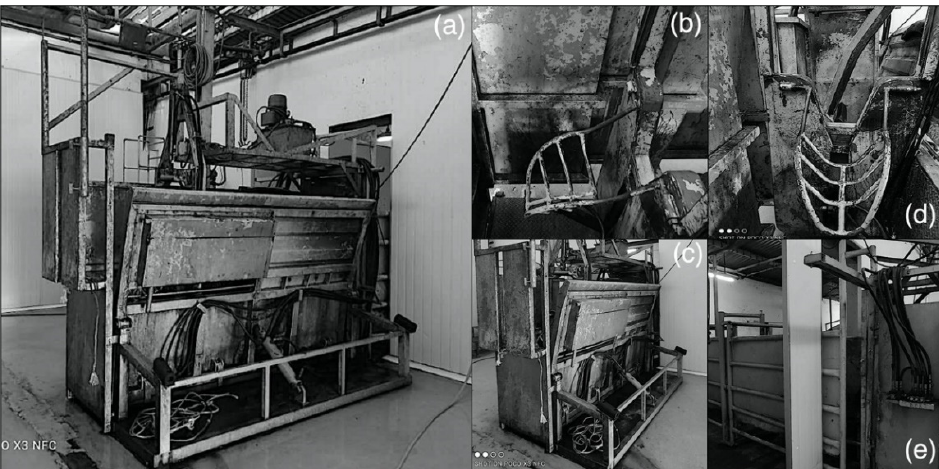
Figure 1. ( a )-Modified MARK IV restraint box. ( b )- chin lift, ( c )- the box showing the part where animal is turned on its lateral side, ( d )- chin lifter and clamp to hold animal while turning on lateral recumbency, ( e )- side view.